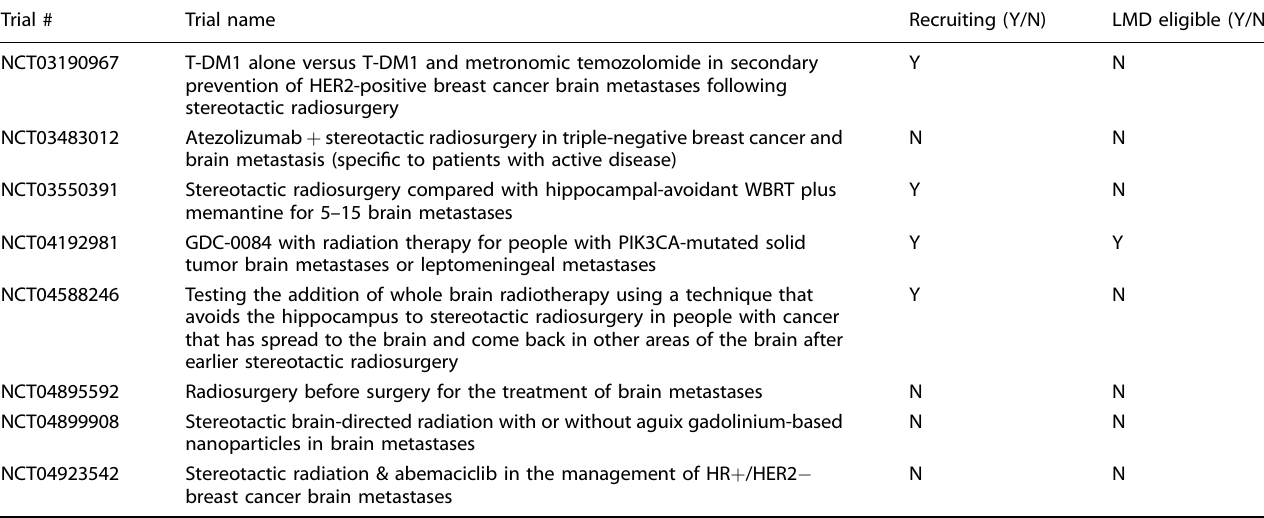
Table 1. A partial list of ongoing clinical trials that include radiation therapy for patients with active and/or stable disease. Trial # Trial